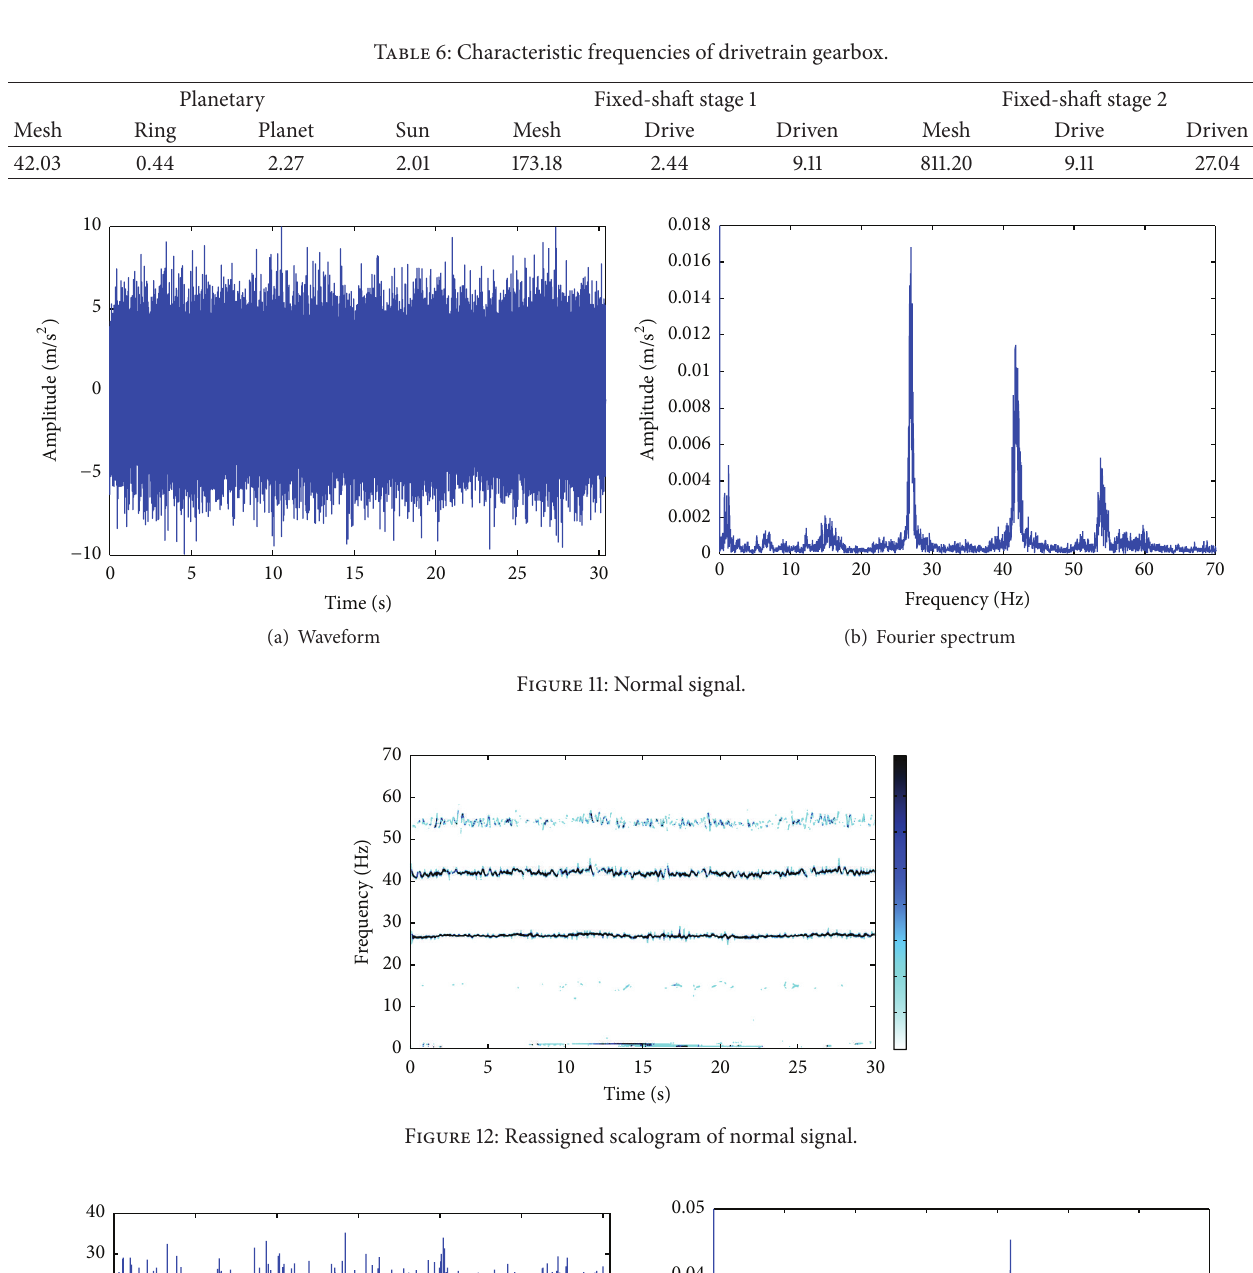
Table 6: Characteristic frequencies of drivetrain gearbox.